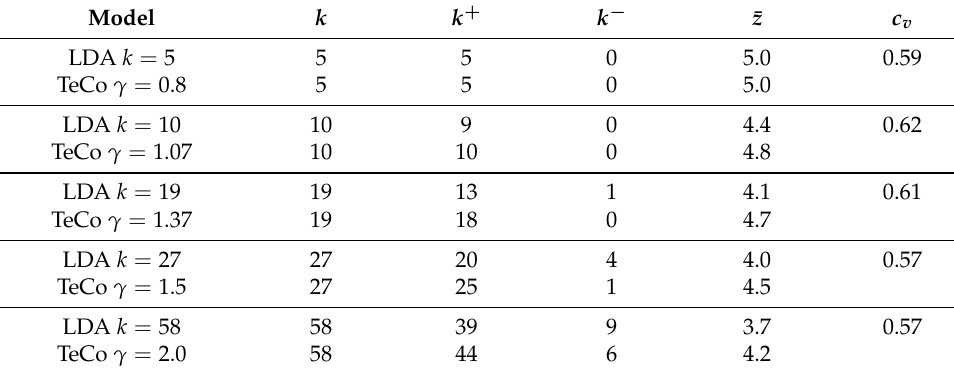
Table 10. Evaluation of topics of the BBC corpus produced with a standard LDA procedure in comparison to term community topics in G 50 ( D BBC ) . In each block, the table shows an LDA model and the corresponding term communities (TeCo) resulting in the same number of topics and lists for each model the number k of topics produced, the numbers k + and k − indicating how many topics the evaluators found easy to interpret (score 5 or 4) and hard to interpret (score 1 or 2), respectively, and the mean score ¯ z of the topics. For LDA models the coherence value c v is also given.